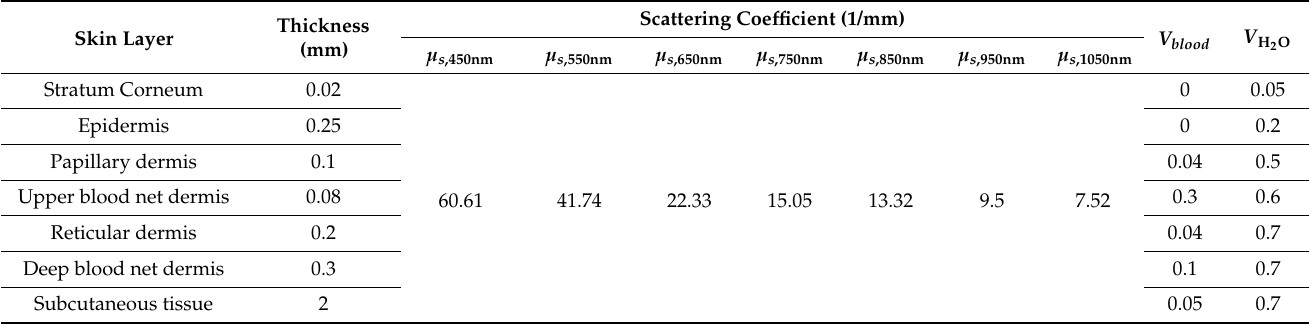
Table 1. Values used in the Monte Carlo skin model based on [28–30] for different skin